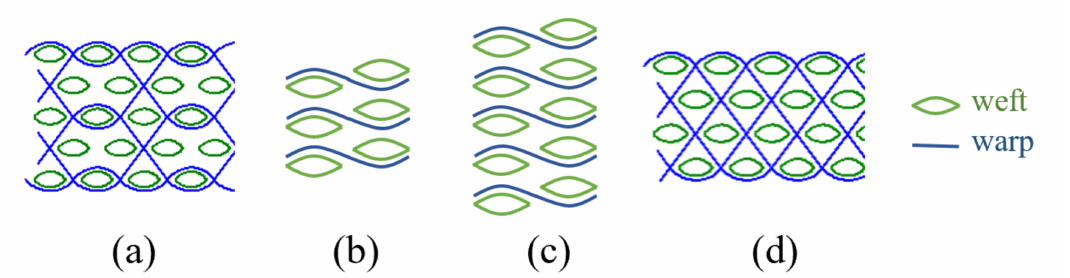
Figure 1. Side views of the fabric panel construction of ( a ) single-ply 3D AI fabric with 5 weft layers; ( b ) 3-ply laminated 2D plain weave fabrics; ( c ) 5-ply laminated 2D plain weave fabrics, and ( d ) single-ply 3D TTAI fabric with 5 weft